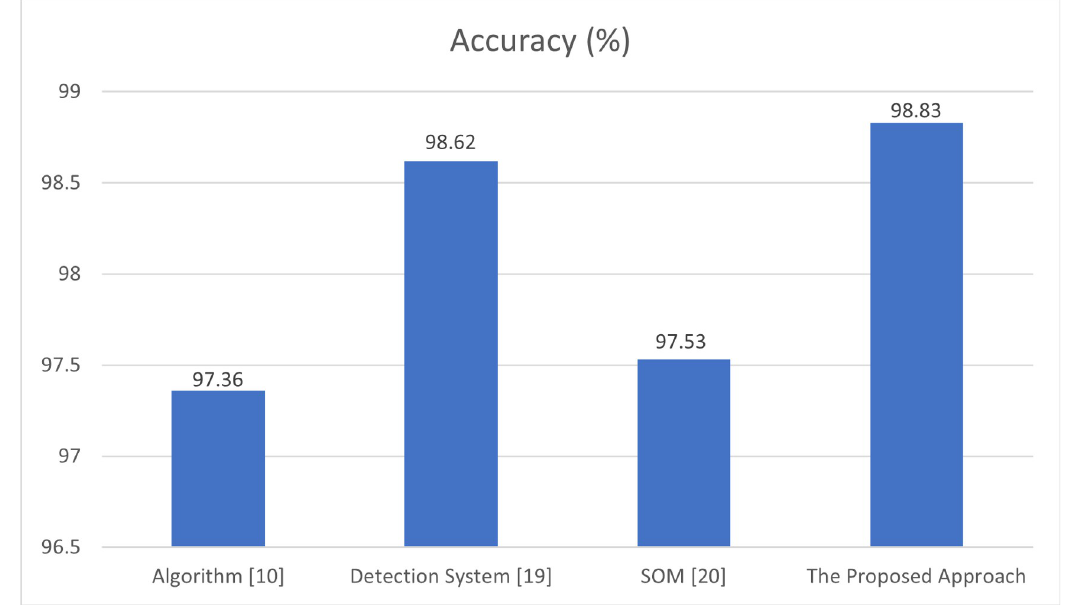
Fig 6. Comparison of accuracy of algorithm [10], detection system [19], detection method [20], and the proposed approach.